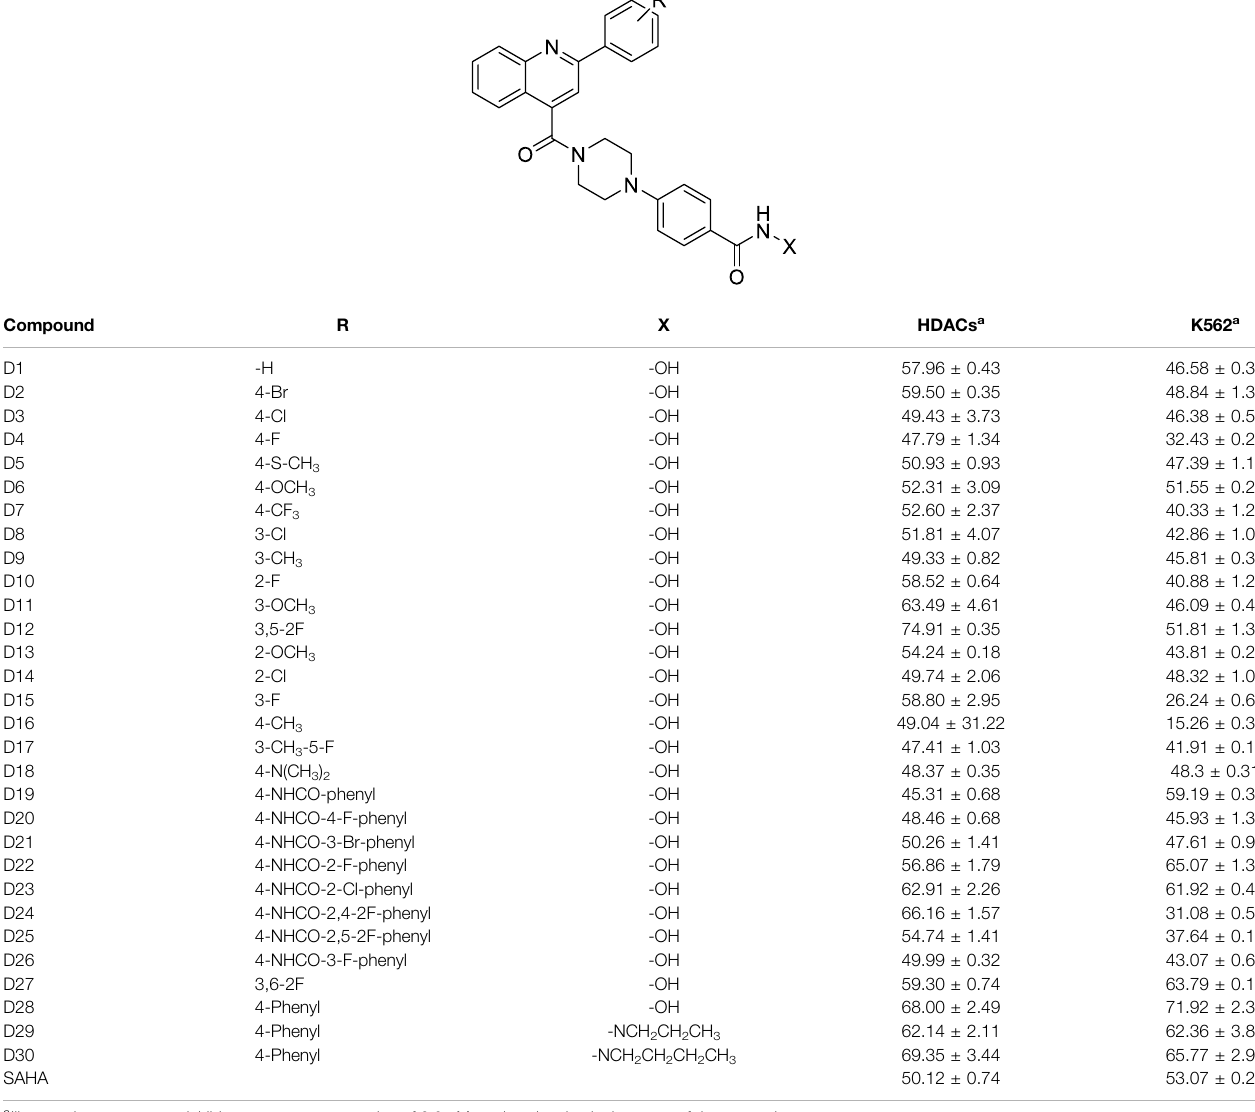
a Illustrated as percentage inhibitory rate at concentration of 2.0 µM, and each value is the mean of three experiments.